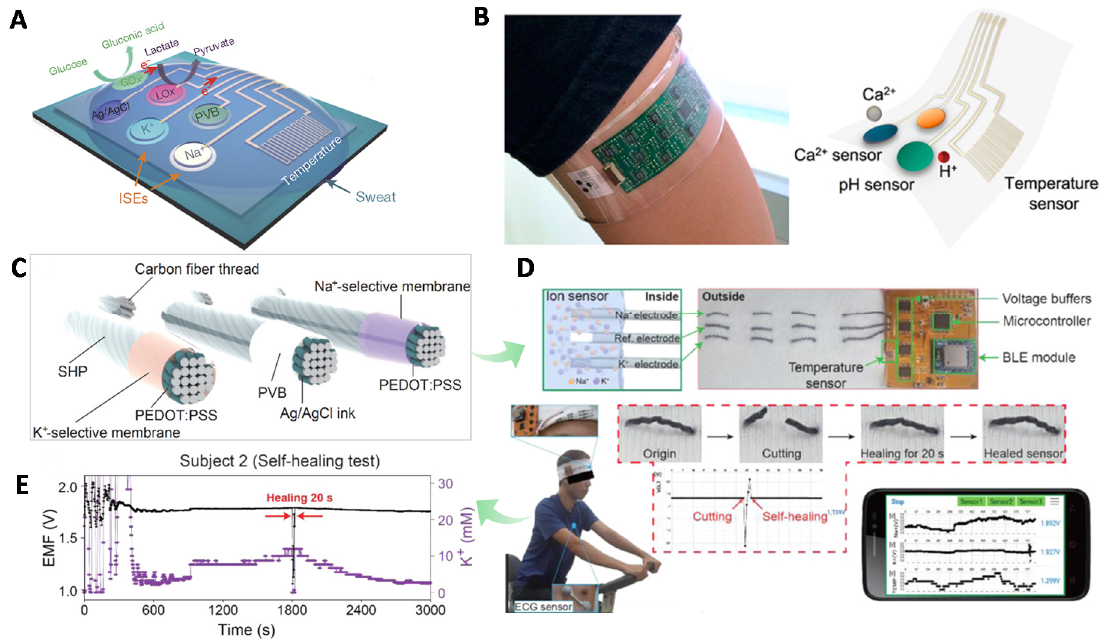
Figure 8. CPs-based wearable SC-ISEs for skin sweat ion sensing. ( A ) An integrated multi-parameter electrochemical wearable sensor involving Na + and K + -SC-ISEs, glucose, lactate and temperature. The PEDOT was used for the SC transducer. Reprinted with permission from [75], Copyright (2016) Springer Nature. ( B ) PEDOT-based wearable SC-ISEs for pH and Ca 2 + sensors. Reprinted with permission from [76], Copyright (2016) American Chemical Society. ( C – E ) PEDOT-based self-healable SC-ISEs for wearable senor. Reprinted with permission from [77], Copyright (2019) American Chemical Society.